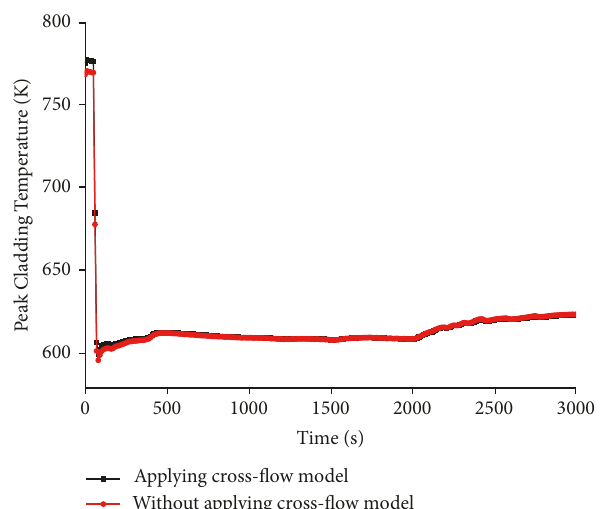
Figure 15: The influence of cross-flow model on